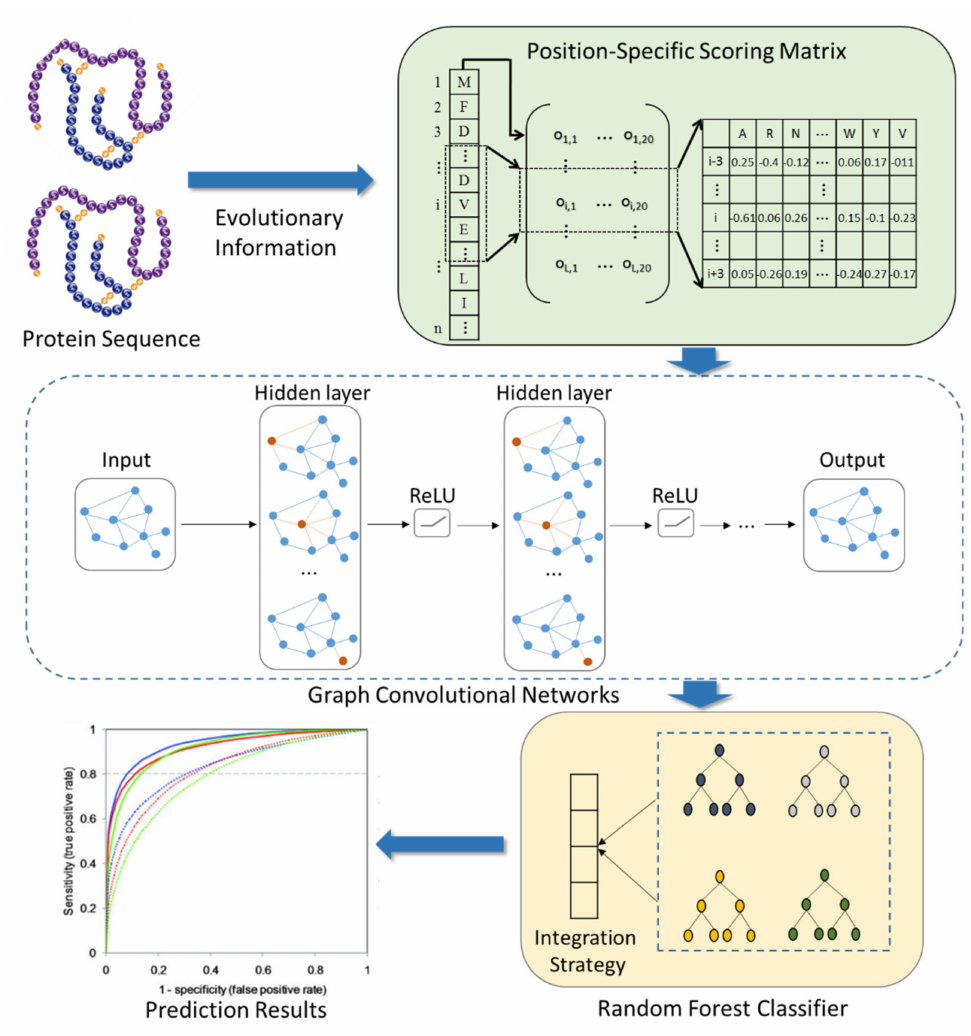
Figure 1. The flowchart of